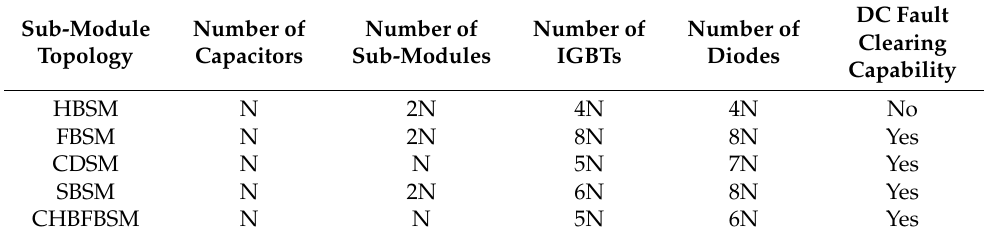
Table 4. Comparison of investment